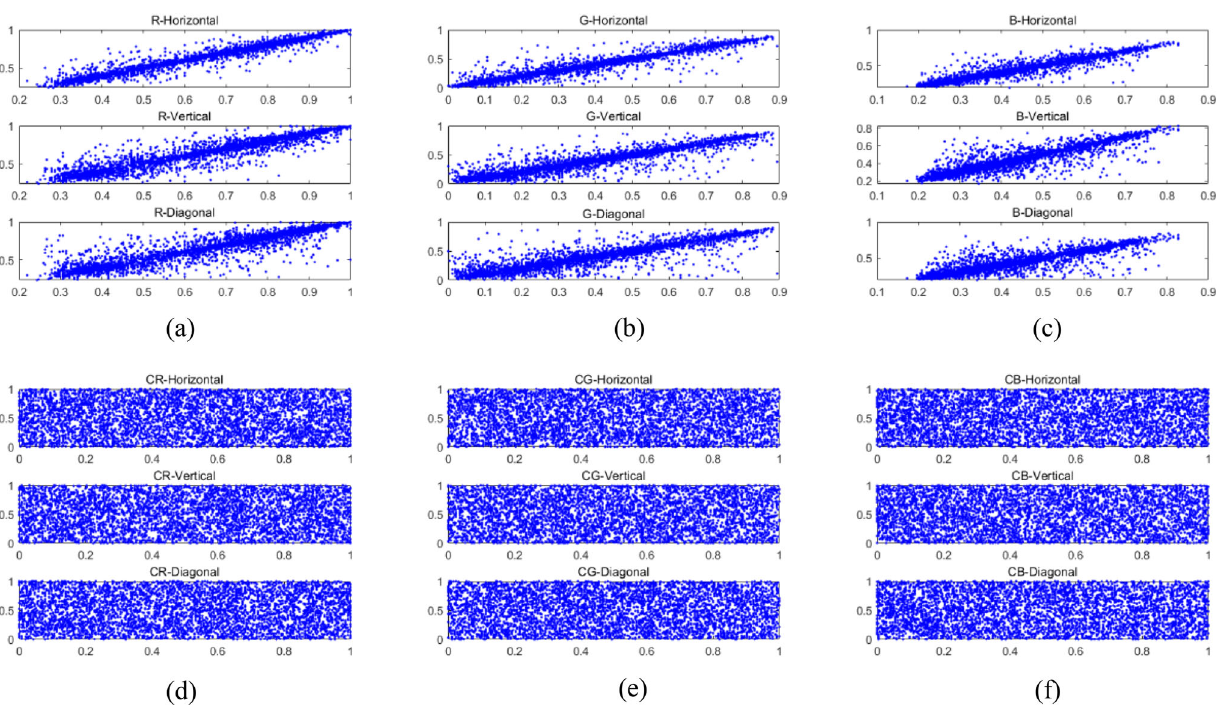
Fig. 11 Adjacent pixel distribution. a – c Adjacent pixel distribution of red, green and blue components of plaintext images; d – f Adjacent pixel distribution of red, green and blue components of ciphertext image Table 7 Information entropy test results